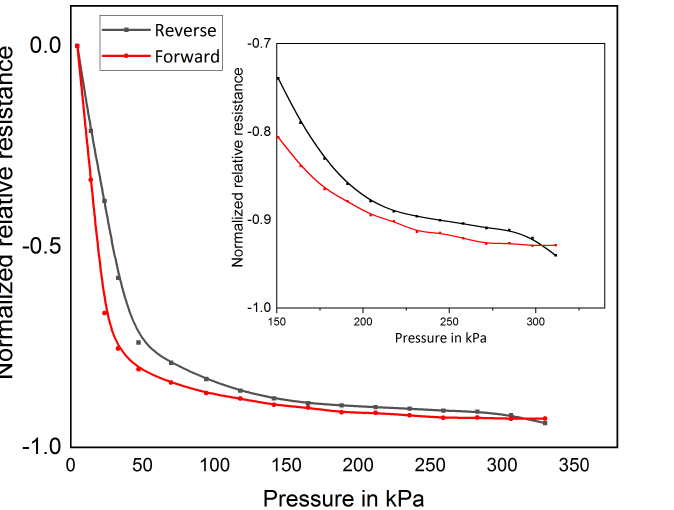
Figure 5. Sensor behavior for forward and reverse force cycle. Inside: Sensor behavior for pressure of 150 to 330